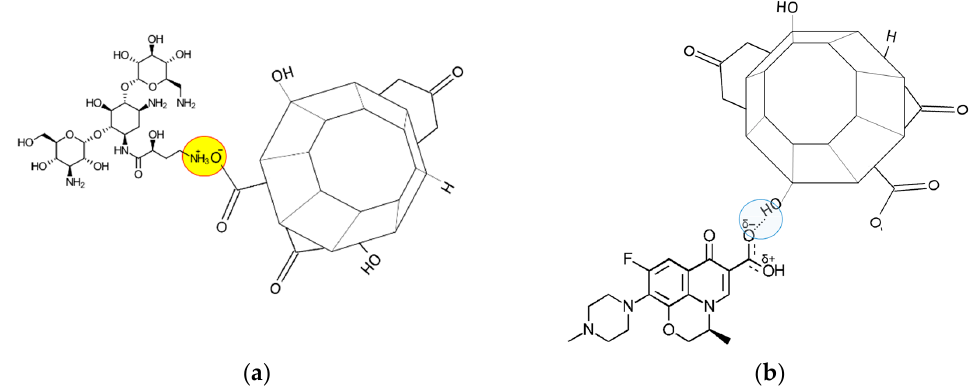
Figure 6. Scheme of the adsorption complex formation between negatively charged nanodiamond and amikacin ( a ) and levofloxacin ( b ).